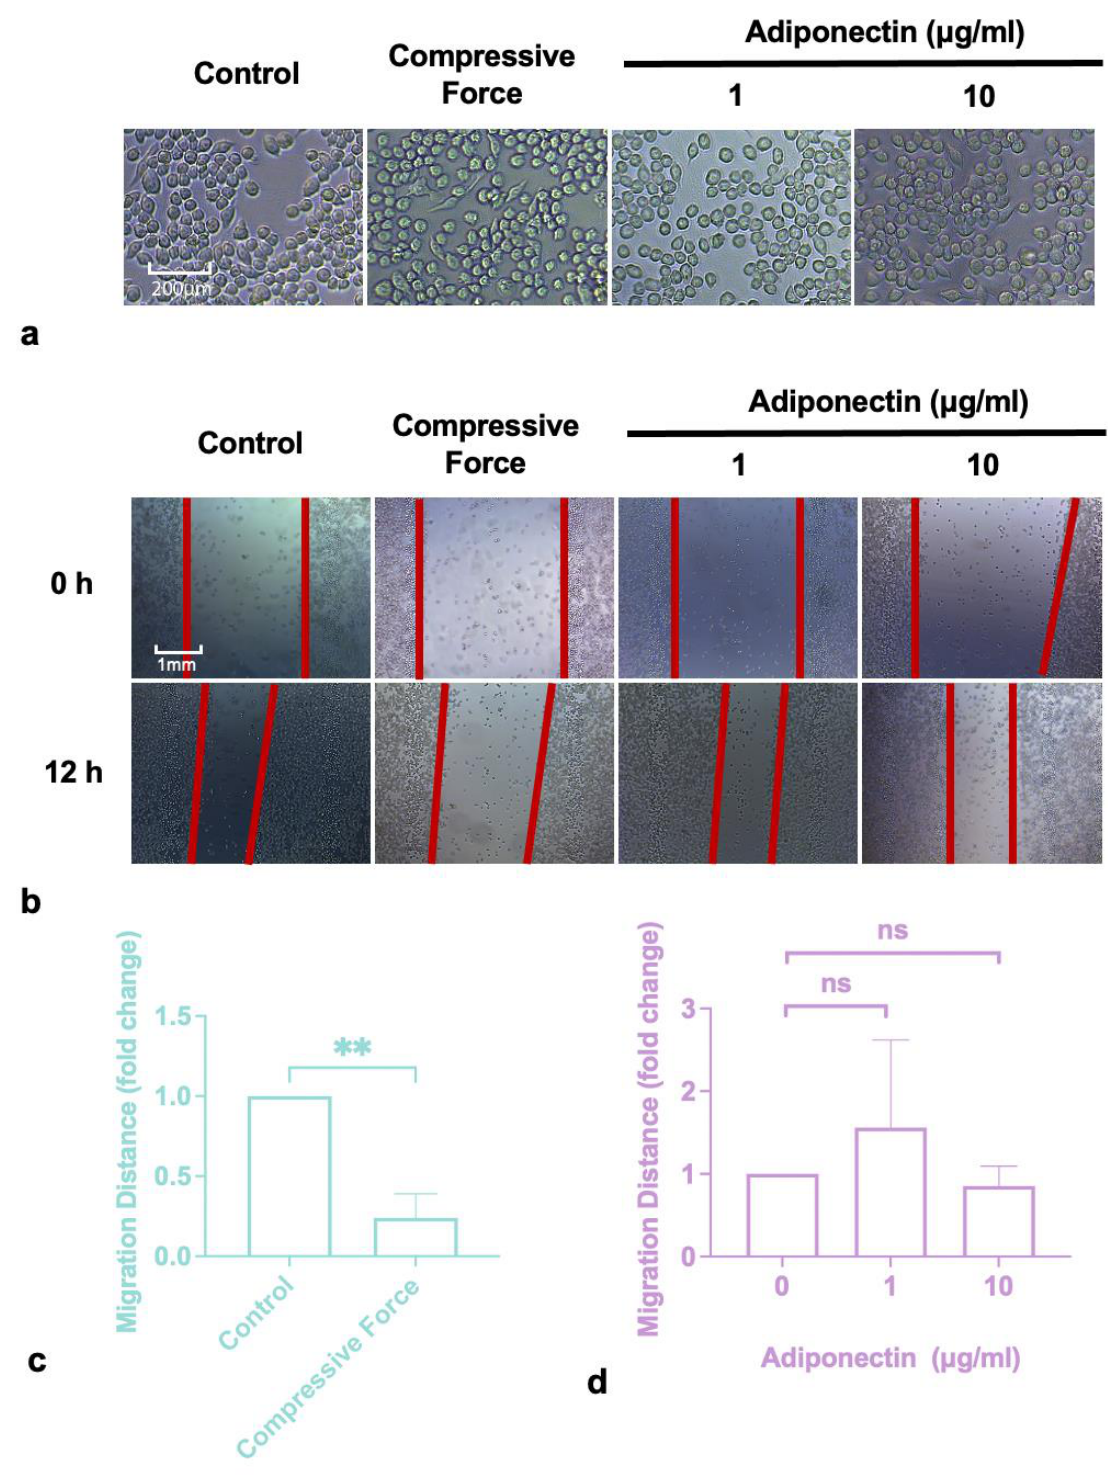
Figure 1. Macrophages were stimulated by the compressive force or adiponectin. ( a ) The effect of compressive force or adiponectin on the morphology of macrophages was negligible. ( b ) The effect of compressive force or adiponectin on the migration of macrophages. ( c ) Compressive force (1 g/cm 2 ) significantly inhibited macrophage migration. ( d ) Neither high nor low concentration of adiponectin had an effect on the macrophage migration rate. Values are expressed as means ± SD; ns — not significant; ** p < 0.01.